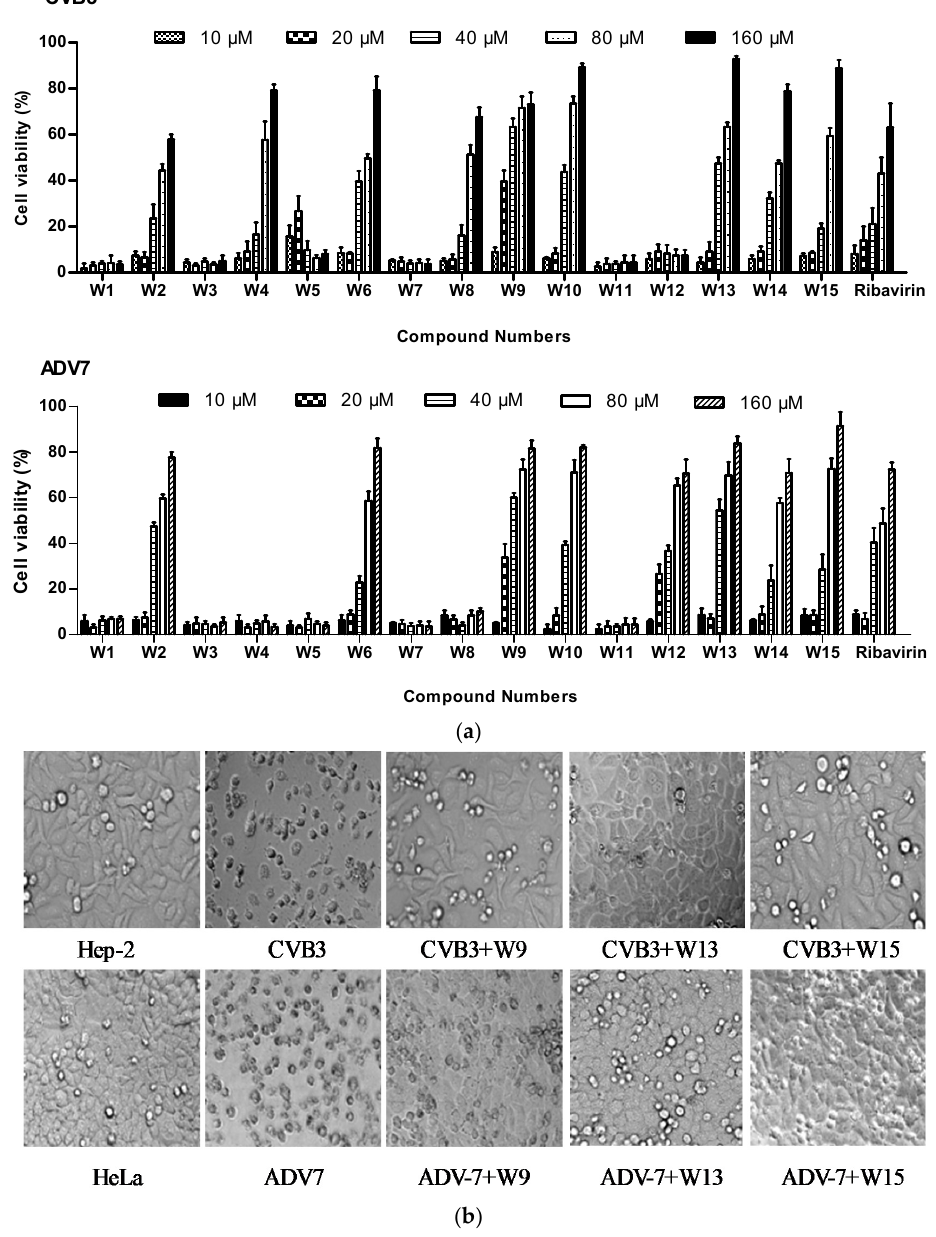
Figure 1. Antiviral activities of novel 2-benzoxyl-phenylpyridine derivatives against CVB3 and ADV7. ( a ) The compounds inhibited virus-induced cytopathic effects (CPEs). Hep-2 or HeLa cells were infected with 100 TCID 50 of CVB3 or ADV7 for 1.5 h at 37 °C. Then, the inocula were aspirated and the cells were incubated with various concentrations of test compounds for 48 h. Cell viability was determined using the MTT assay. ( b ) Images showing the morphology of Hep-2 and HeLa cells treated with 120 μ M W-9, 160 μ M W-13, or 160 μ M W-15 (magnification, 20×).